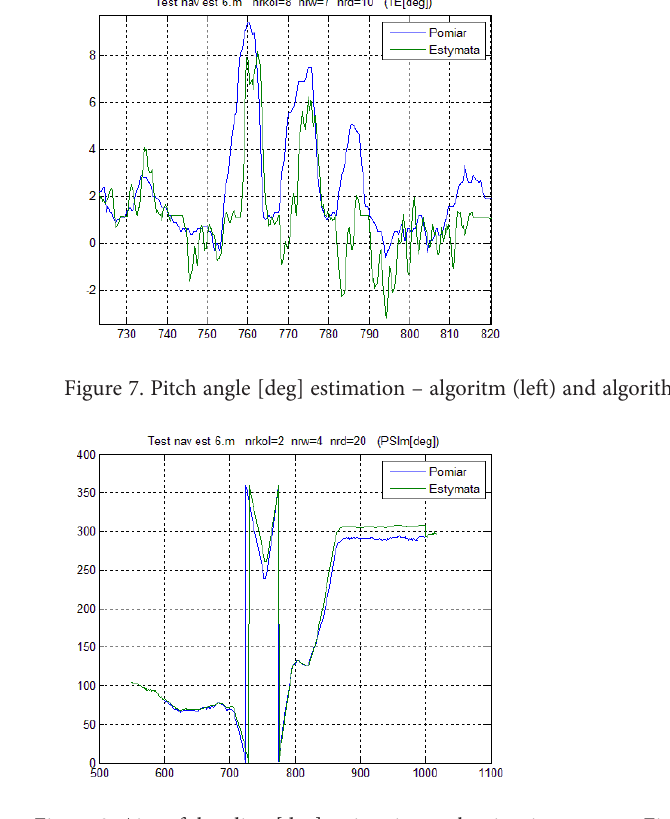
Figure 8. Aircraft heading [deg] estimation – algoritm is described in sub-chapter 2.7